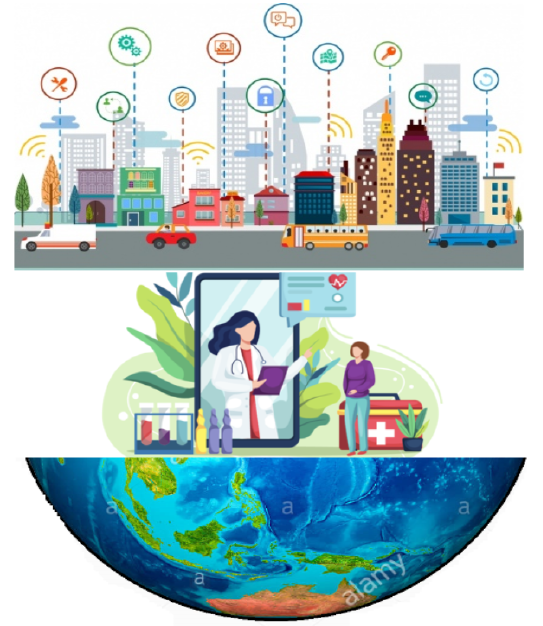
Figure 1. eHealth in smart